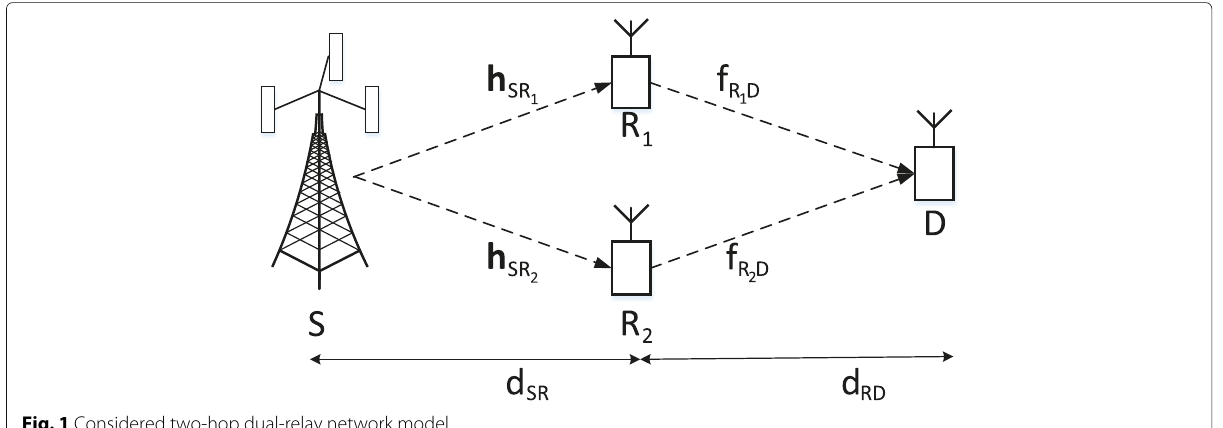
Fig. 1 Considered two-hop dual-relay network